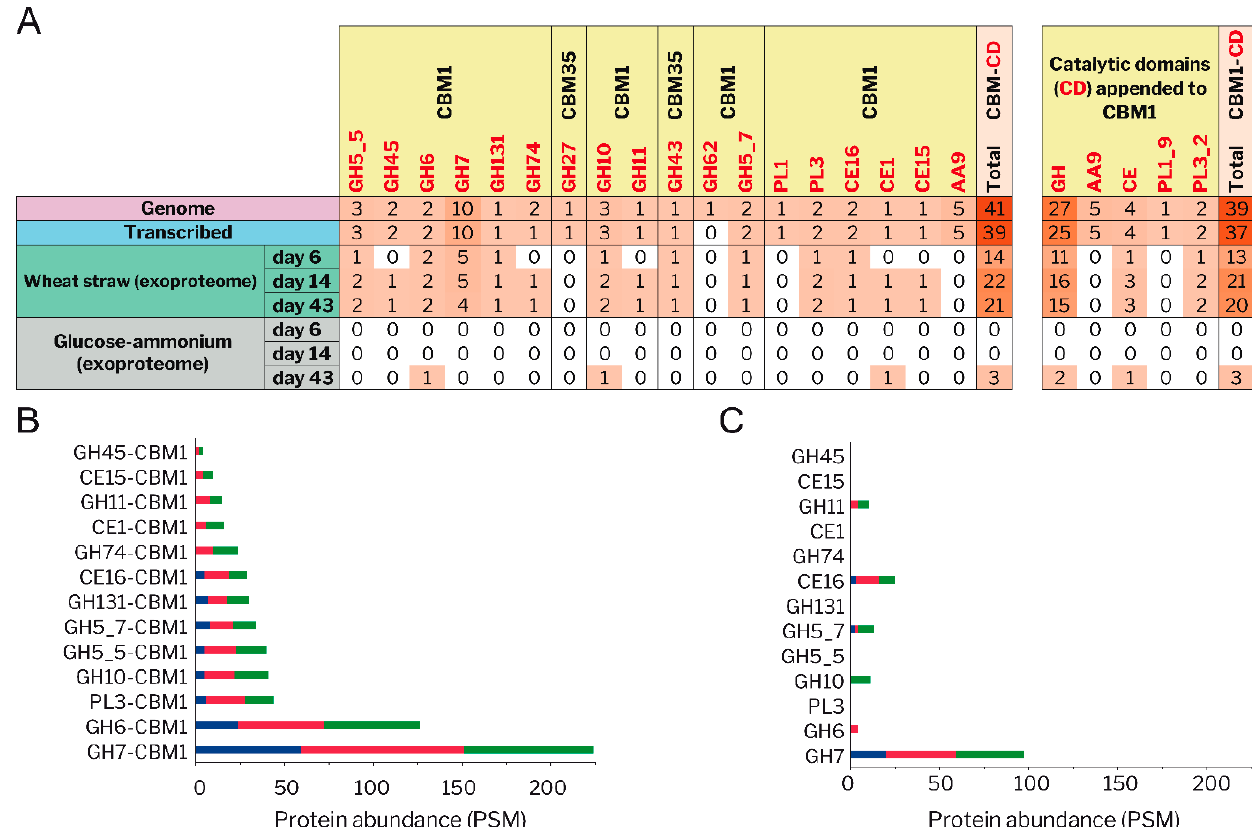
Figure 10. CBM-containing PCWDEs: ( A ) Catalytic domains (GHs, PLs, CEs and AA9 LPMOs) appended to CBM1 and CBM35 modules in the P. eryngii genome, transcriptome, and exoproteomes from wheat–straw , and glucose–ammonium cultures. ( B , C ) Abundances of catalytic domains appended and non-appended to CBM1, respectively, in the wheat–straw exoproteome after 6 (blue), 14 (red) and 43 (green) days of culture.